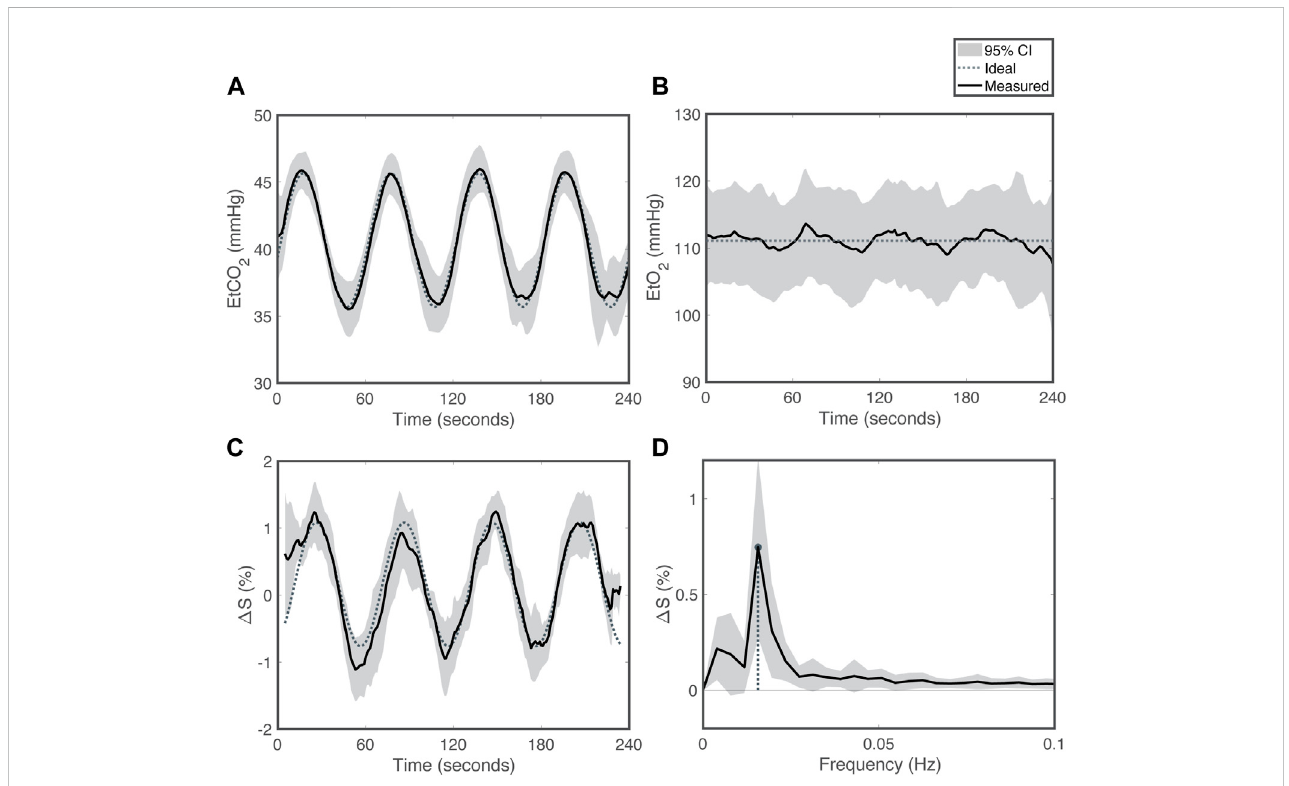
FIGURE 1 Respiratory challenge patterns for SineCO 2 (A) End-tidal carbon dioxide (EtCO 2 ), (B) end-tidal oxygen (EtO 2 ), (C) percent signal change in the time domain and (D) in the frequency domain. Grey shading re fl ects 95% con fi dence interval. Dotted line represents the targeted sequence, and solid line is the average time series measured in the